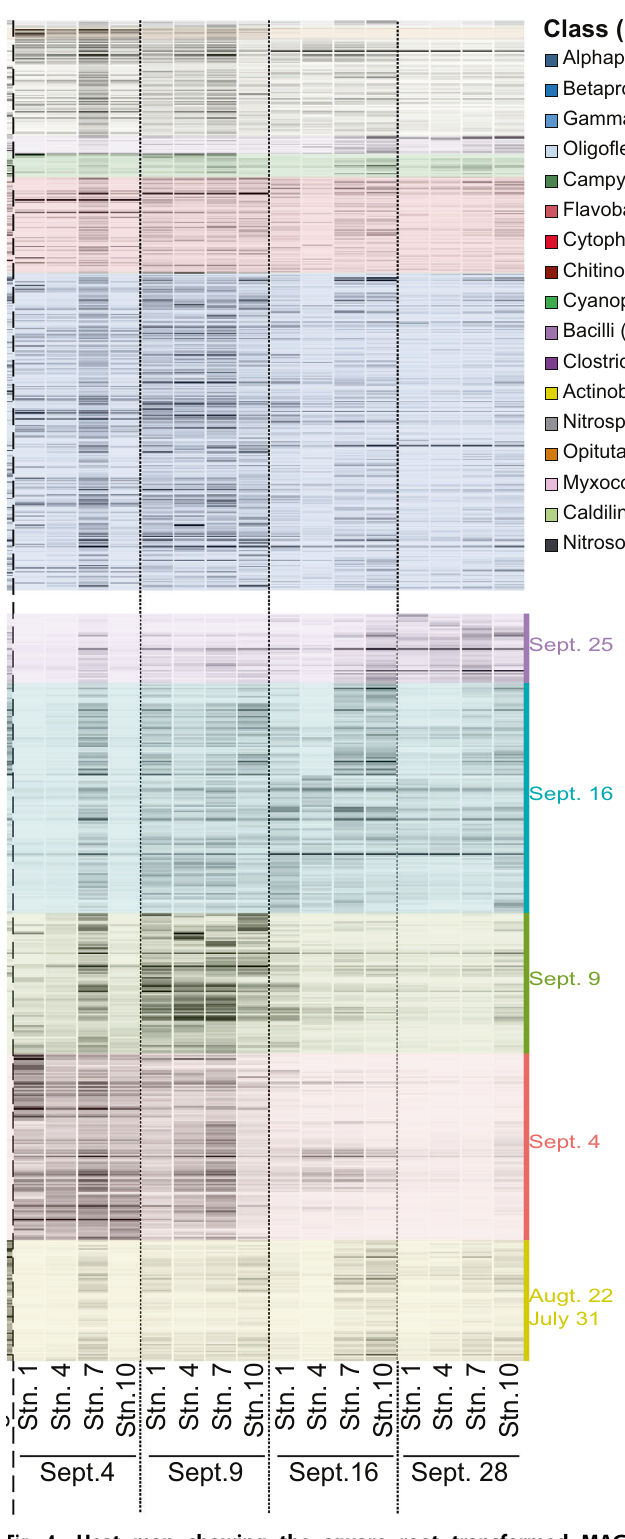
Fig. 4 Heat map showing the square root transformed MAG percent community as calculated by CheckM. The MAGs were grouped according to taxonomic classi fi cation ( A ) or hierarchical clustering of the MAG percent community ( B ). Each row represents a high or medium quality MAG and the intensity of the bands represent their prevalence in each metagenome (columns). Color bars on the far left and background shading in ( A ) correspond to the class of the MAG as determined by Kraken2.